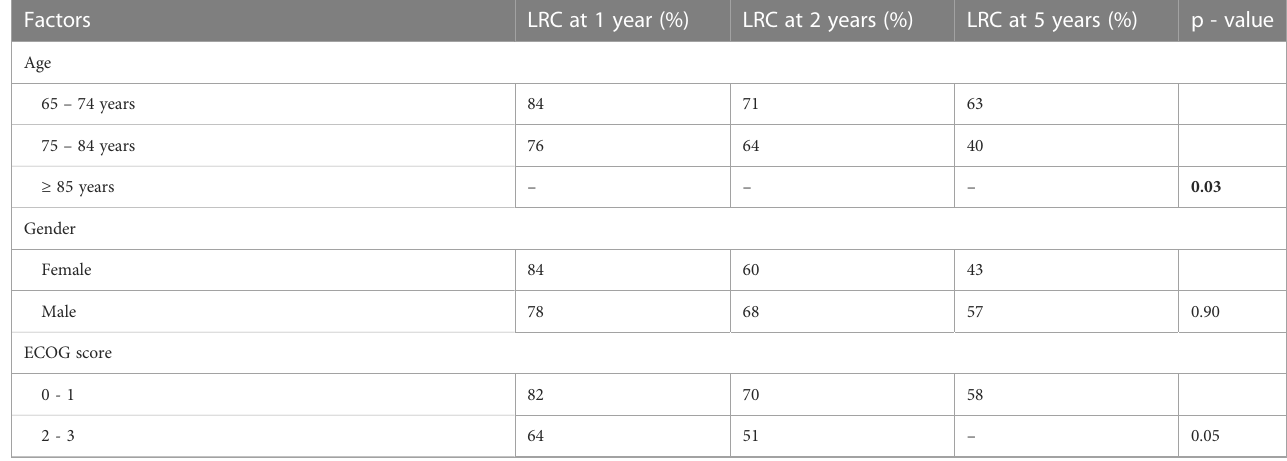
TABLE 2D Univariate analyses of potential prognostic factors for locoregional control (LRC).